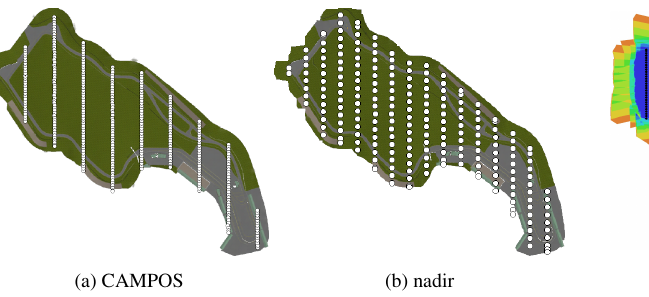
Figure 5. Location of photos with each survey technique.